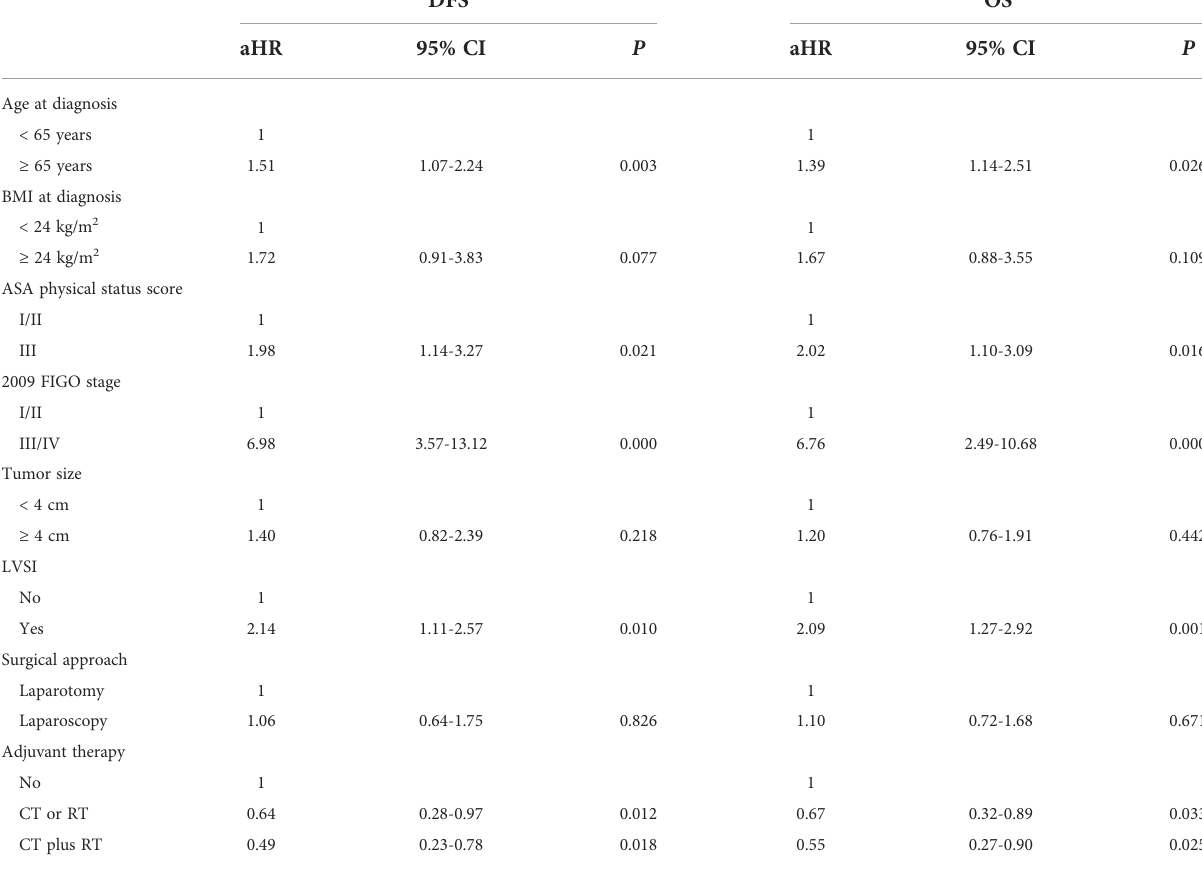
TABLE 4 Multivariate analyses of survival for apparent early-stage uterine clear cell